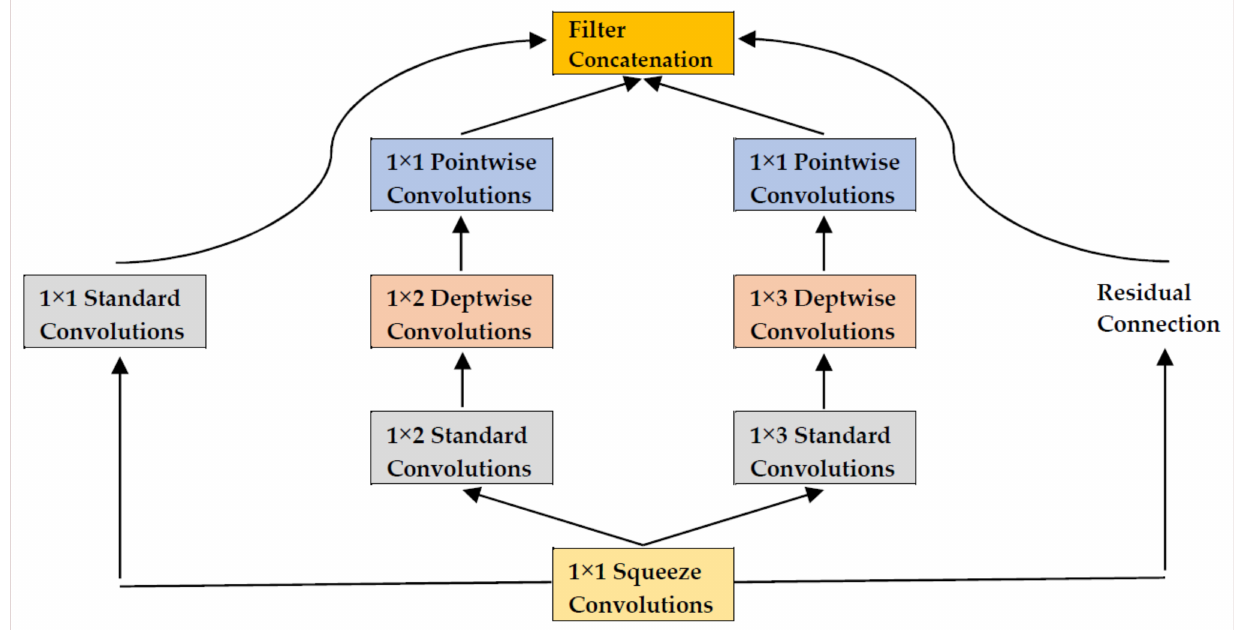
Figure 8. Lite Module. Source: [23].